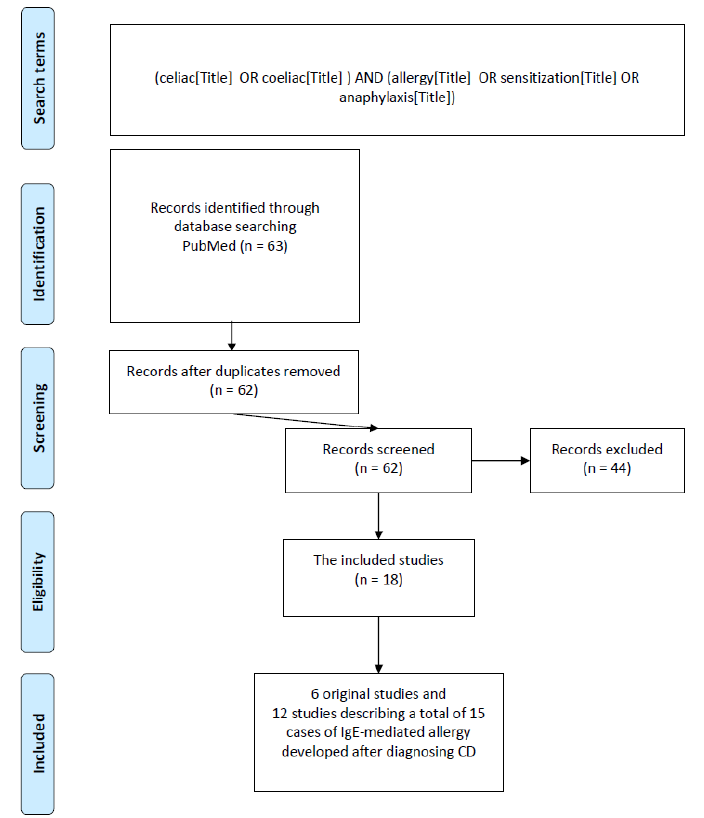
Figure 1. Flow chart showing the process for inclusion of studies [13].